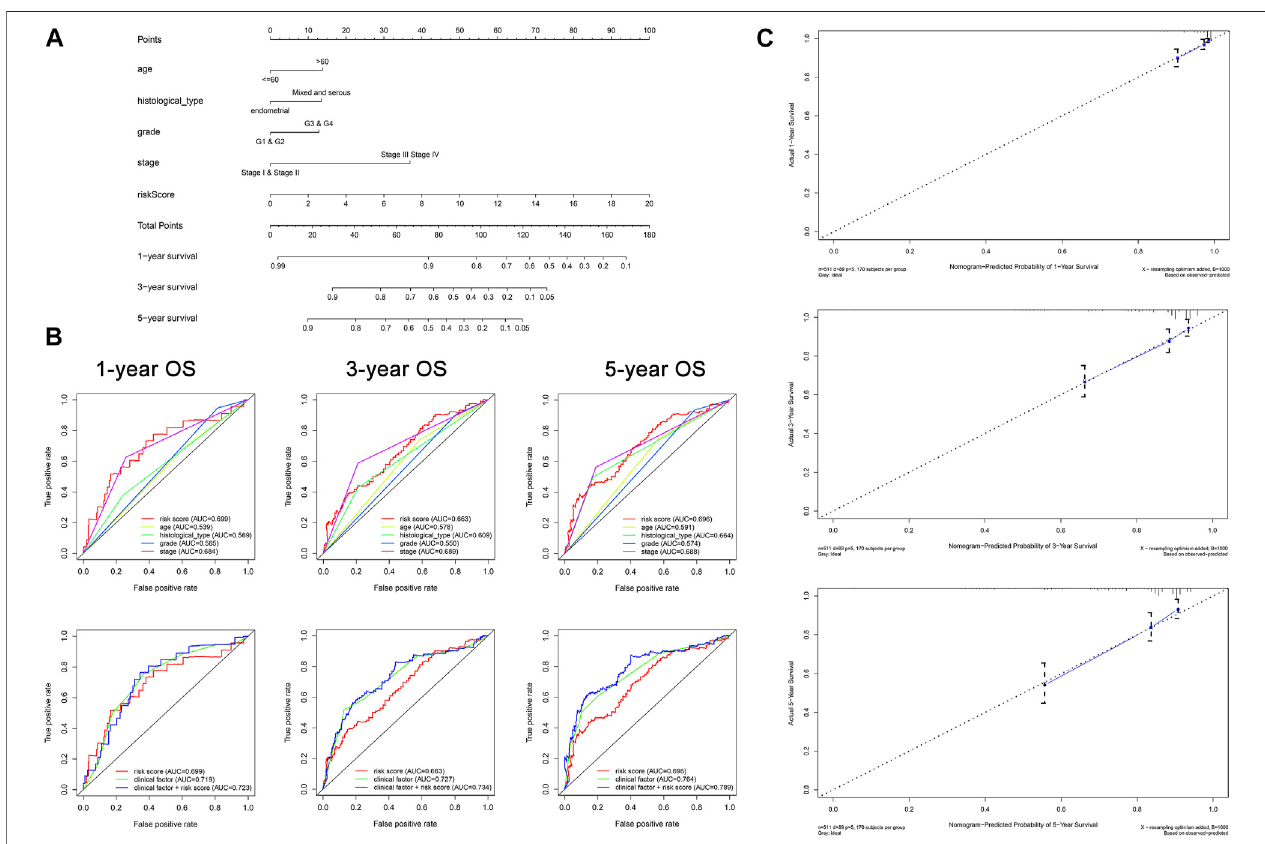
FIGURE 4 | Construction of nomogram for predicting survival of patients with UCEC ( N (cid:1) 511). (A) The baseline nomogram including fi ve factors: patient age, histologicaltype,tumorgrade,tumorstage,andriskscore. (B) ROCcurvesof1-,3-,and5-yearsOSindicatedthatthegene-basedsignaturehadbetterpredictiveability compared with other clinical characteristics. In addition, the nomogram composed of the signature and clinical characteristics showed superior prediction value for the prognosis. (C) Calibration plots of 1-, 3-, and 5-years OS suggested that the prognosis predicted by the nomogram was consistent with the actual outcome.